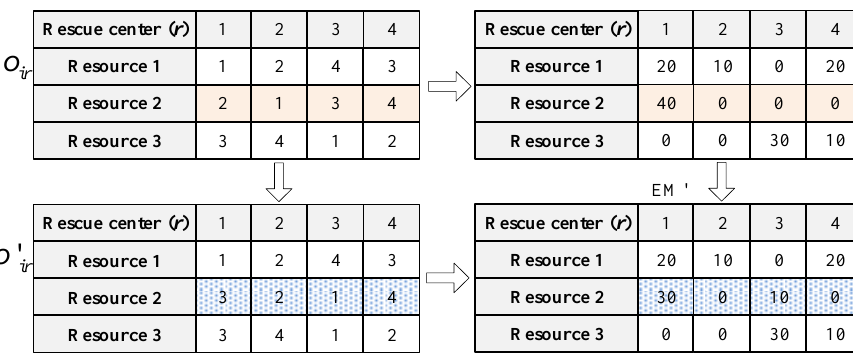
Figure 6. Illustration of mutation for sub-chromosome EM.